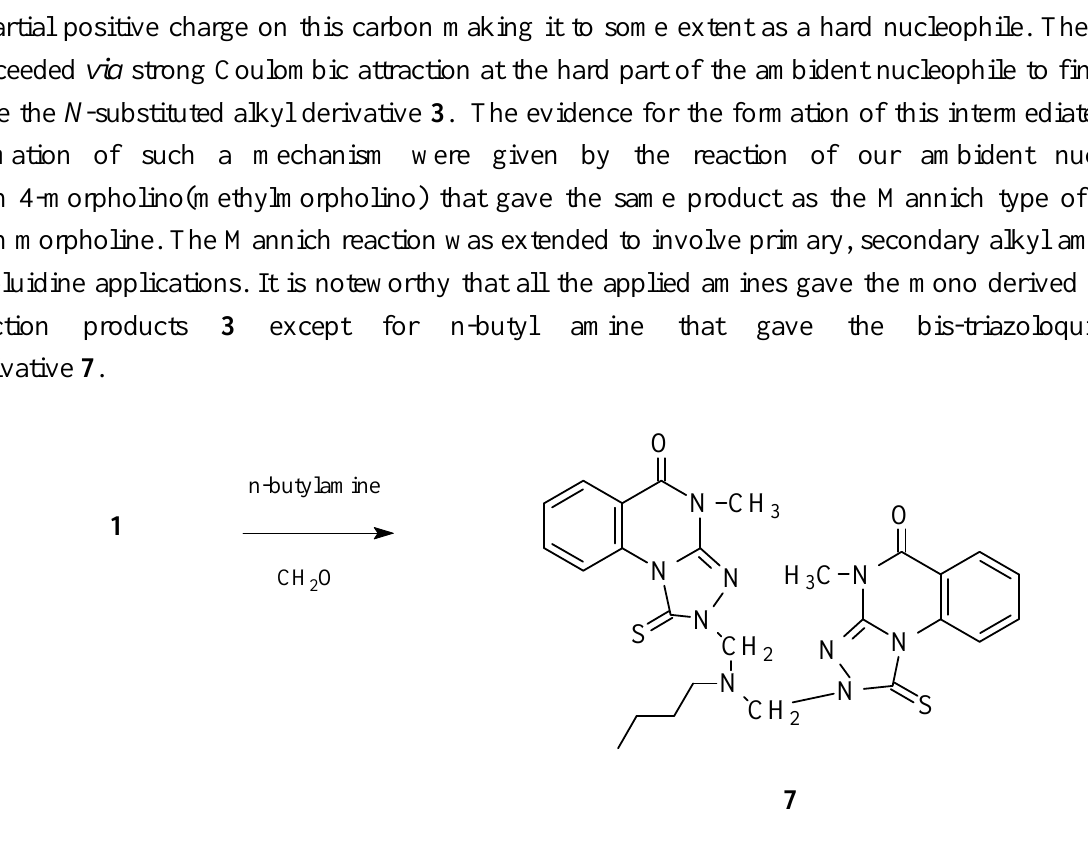
Scheme 2. Reaction of 1 with n-butyl amine and